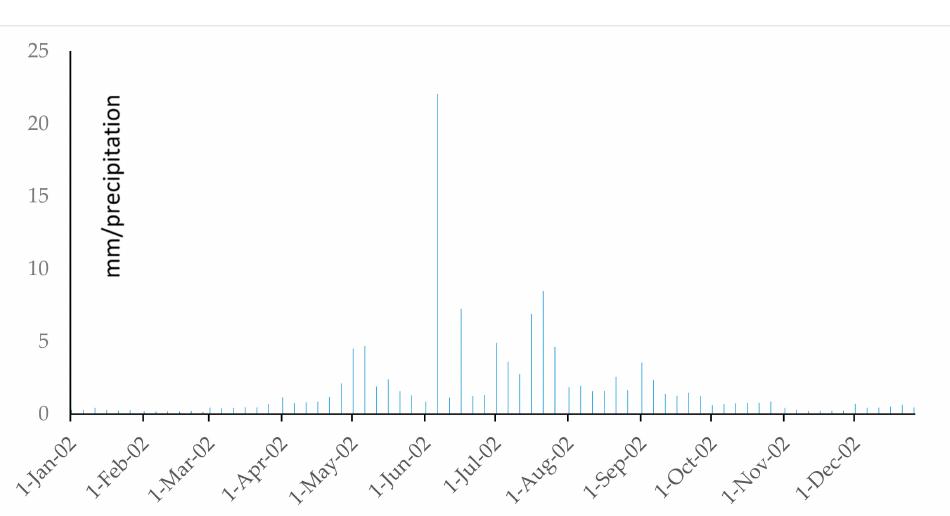
Figure A29. Precipitation of Denko County in 2001.